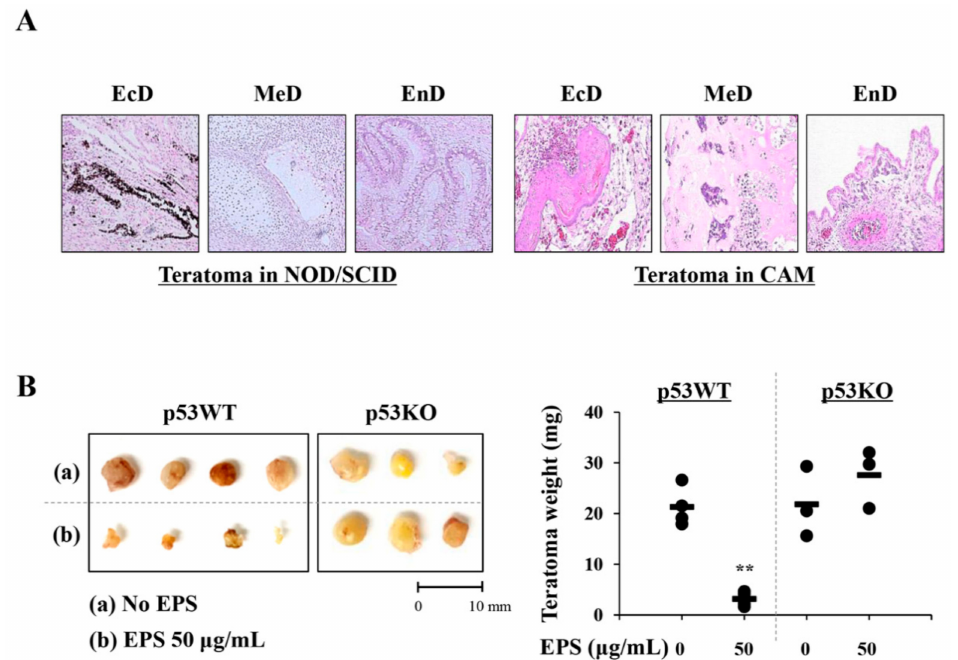
Figure 8. EPS treatment blocks in ovo teratoma formation by undi ff erentiated hiPSCs. ( A )